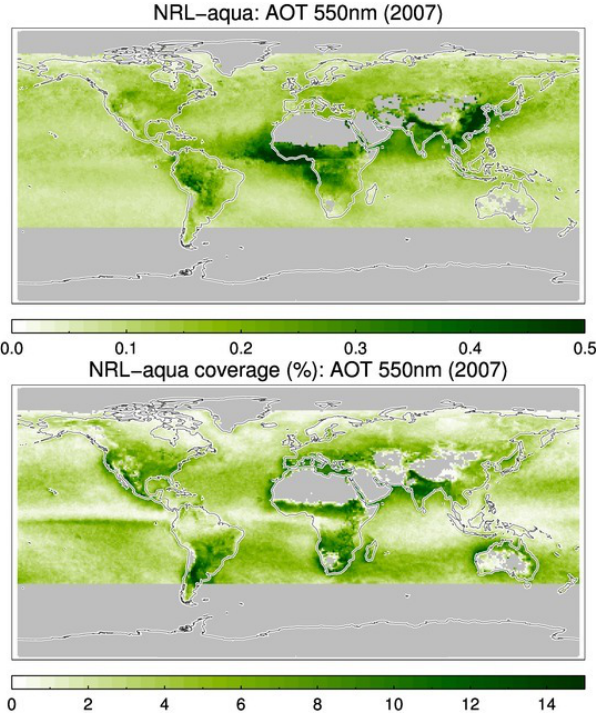
Figure 7. Top panel shows the 2007 yearly mean AOT of MODIS- NRL Aqua. Bottom panel shows the temporal coverage (%) of ob- servations during that year. Grey colours indicate no observations available at all.